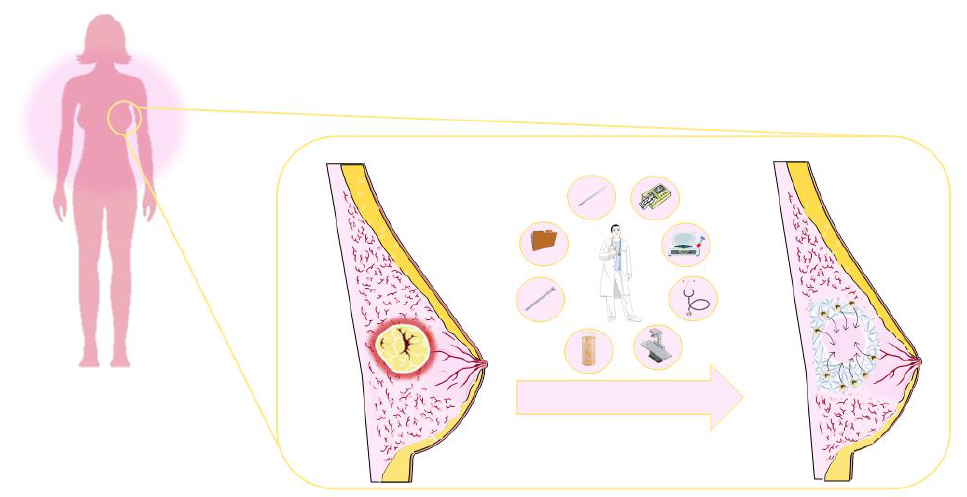
Figure 8. Schematic representation of the clinical application of PTX-loaded poly-lactide-co-glycolic-acid (PLGA) nanoparticles embedded in collagen-based hydrogels.